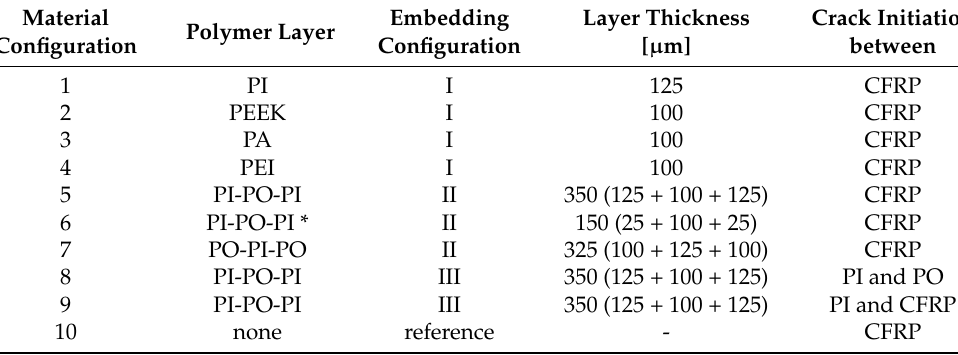
Table 1. Investigated material and embedding configurations.